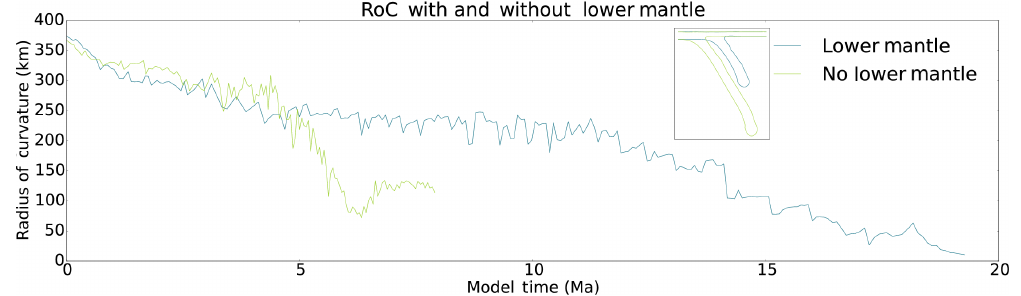
Figure 5. The radius of curvature (RoC) over time for models 18 and 36, each with the same parameters, except for the presence of a lower mantle. The inset shows the 1550K isotherm for each of the models at 4.4Ma. The tip of the slab in model 18 (with a lower mantle) has descended to a depth of 625km, while in the same time the tip of the slab in model 36 (no lower mantle) is at a depth of 1180km.